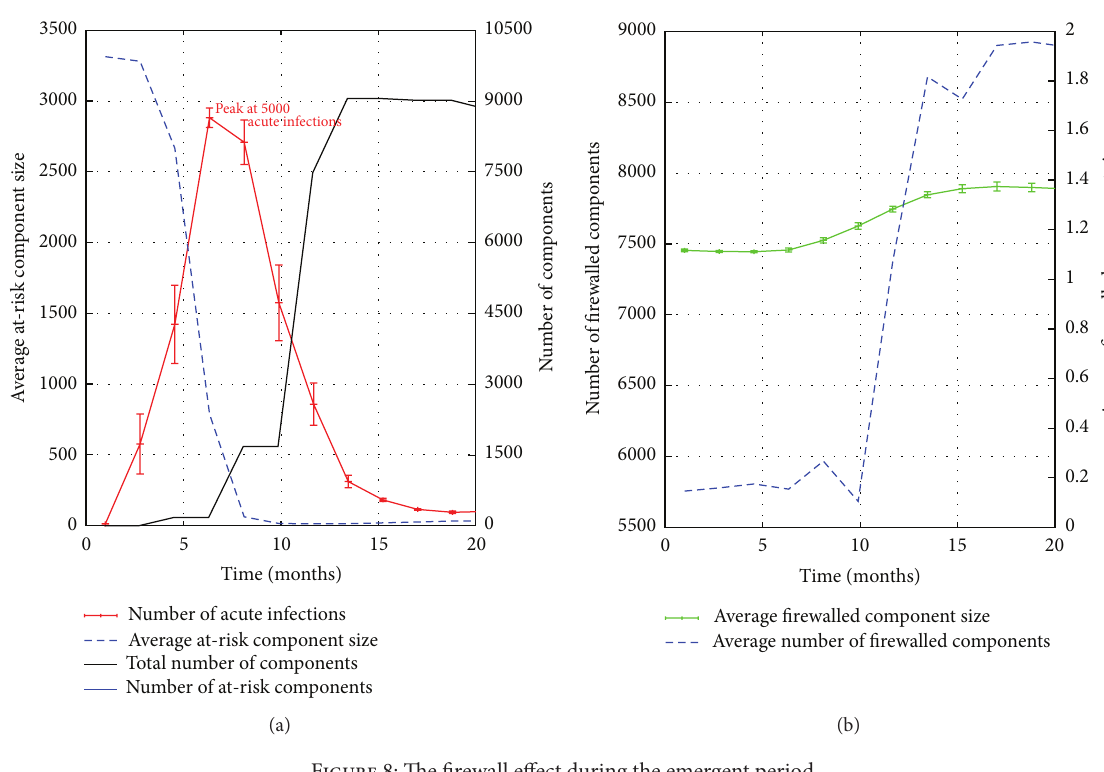
Figure 8: The firewall effect during the emergent